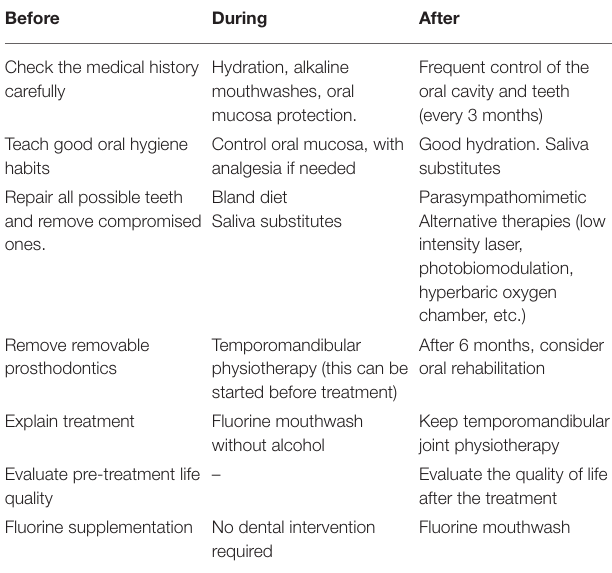
TABLE 2 | Dental assessment and interventions to be performed in HNC patients before, during, and after treatment. Before During